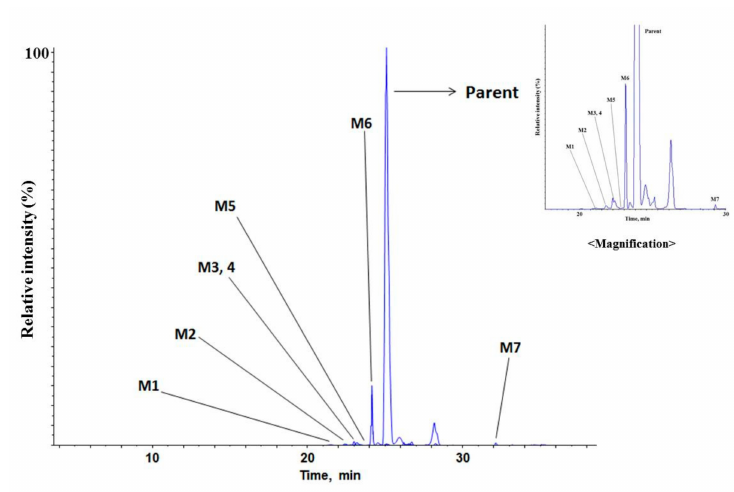
Figure 5. Total ion chromatogram of MMAF (monomethyl auristatin F) and its metabolites in human liver microsome.